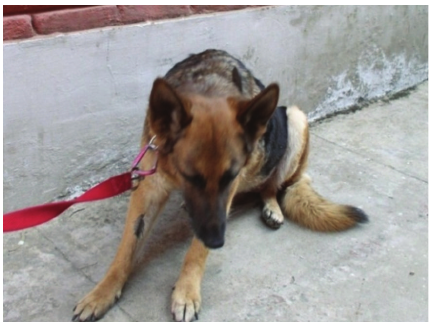
Figure 27: Cranial abdominal discomfort exhibited by a nine-year- old spayed female German Shepherd Dog with hepatic and splenic mass by assuming “position of relief.”